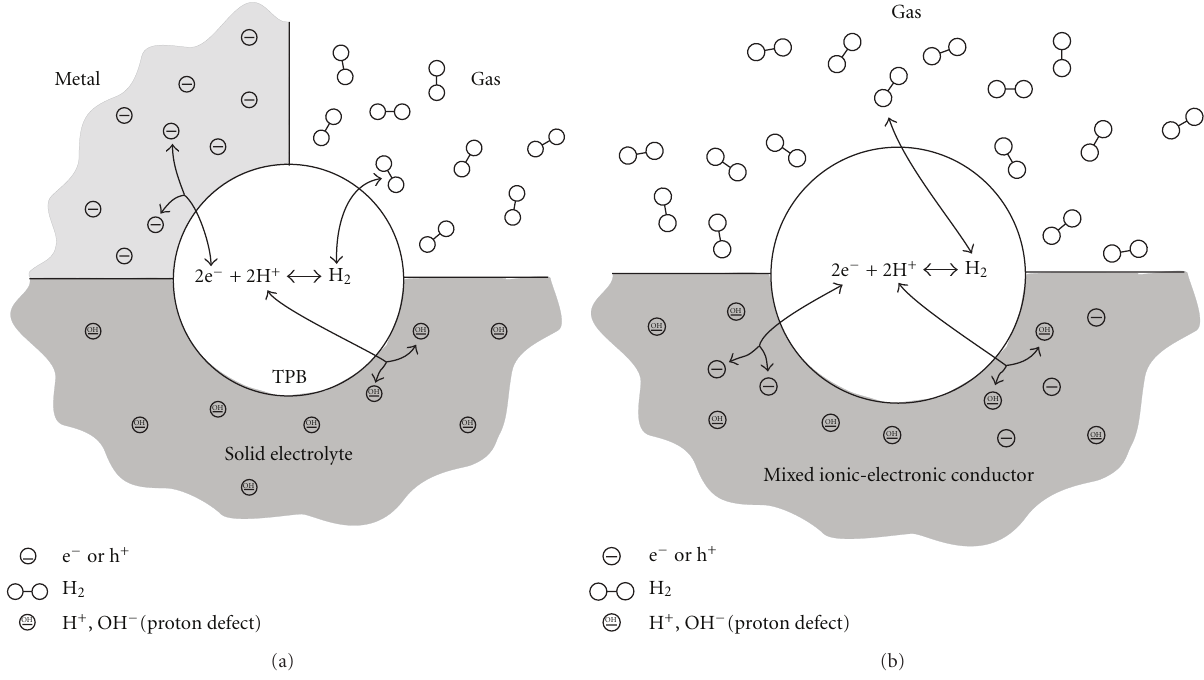
Figure 2: Electrode reaction models with contribution of: (a) solid state electrolyte, (b) ionic-electronic conductor.